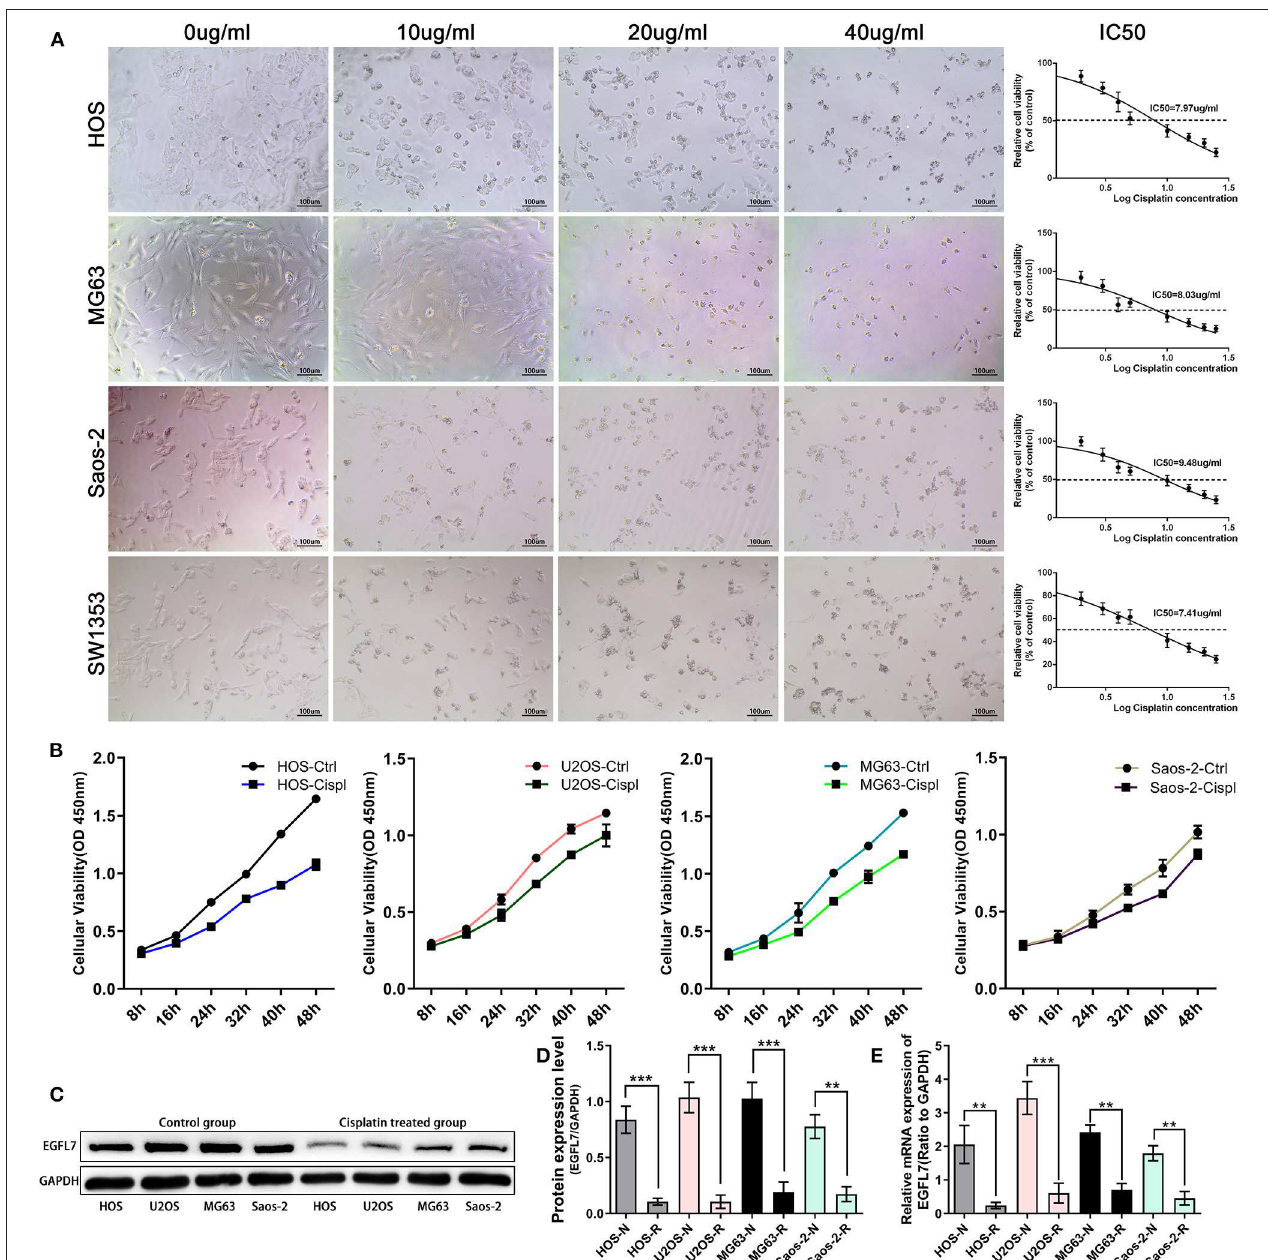
FIGURE 4 | The expression of EGFL7 deregulated in OS cells after cisplatin intervention. (A) Intervention of four osteosarcoma cell lines with different gradient concentration of cisplatin. Under light microscope, the number of cells changed significantly with different concentrations of cisplatin. The toxicity of cisplatin was detected by CCK-8 kit and the corresponding IC50 of various cells was calculated. (B) The results showed that cisplatin could significantly affect the proliferation rate of tumor cell lines. (C,D) Western blot was assessed to compare EGFL7 protein in OS cells before and after Cisplatin intervention, the results showed that the expression of EGFL7 protein deregulated after Cisplatin intervention. Paired T test showed that EGFL7 protein expression in OS cells was significantly deregulated after cisplatin intervention and the difference was statistically significant. (E) RT-PCR results showed that the transcription level of EGFL7 mRNA in OS cell lines was significantly deregulated after cisplatin intervention and the difference was statistically significant. PCR and western blot experiments were all performed in triplicate. * P < 0.05, ** P < 0.01, *** P < 0.001.